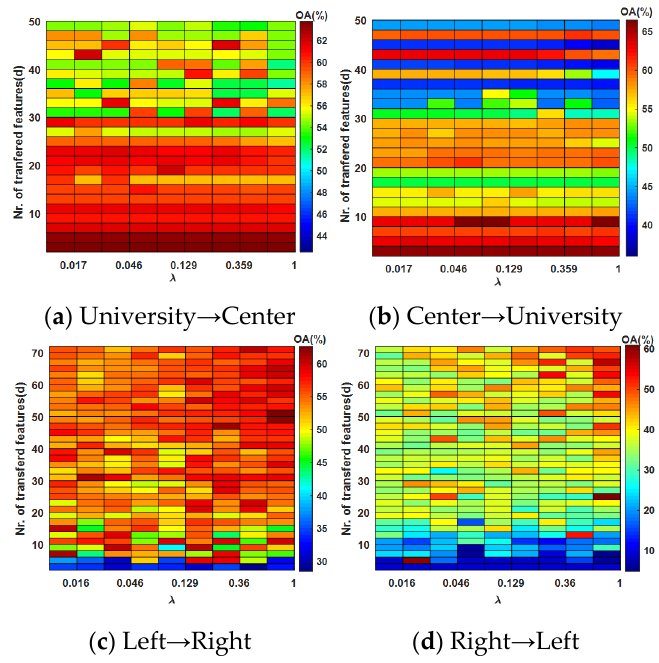
Figure 7. OA versus the number of subspaces d and the parameter λ of ITLDC for the ROSIS ( a , b ) and Houston ( c , d ) data sets: (Source → Target).